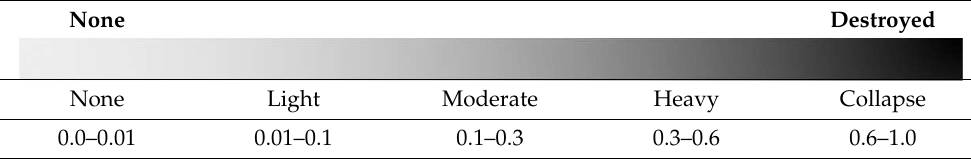
Table 4. Description of building damageability intervals (compiled based on ATC-13 [62]).